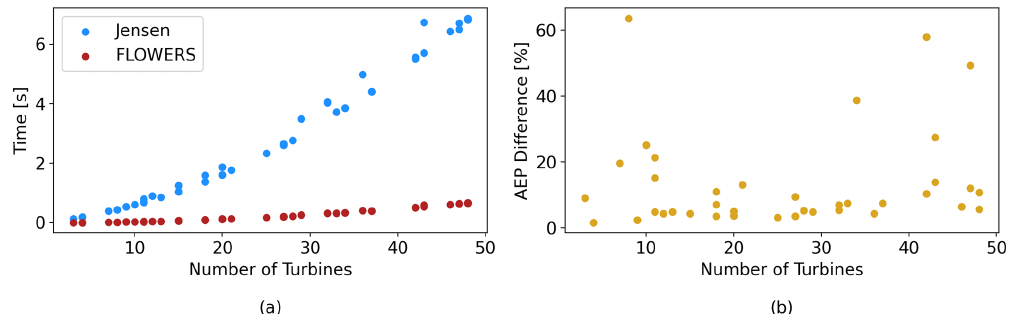
Figure 6. Comparison of computational cost and relative difference in AEP between FLOWERS and Jensen for the randomized